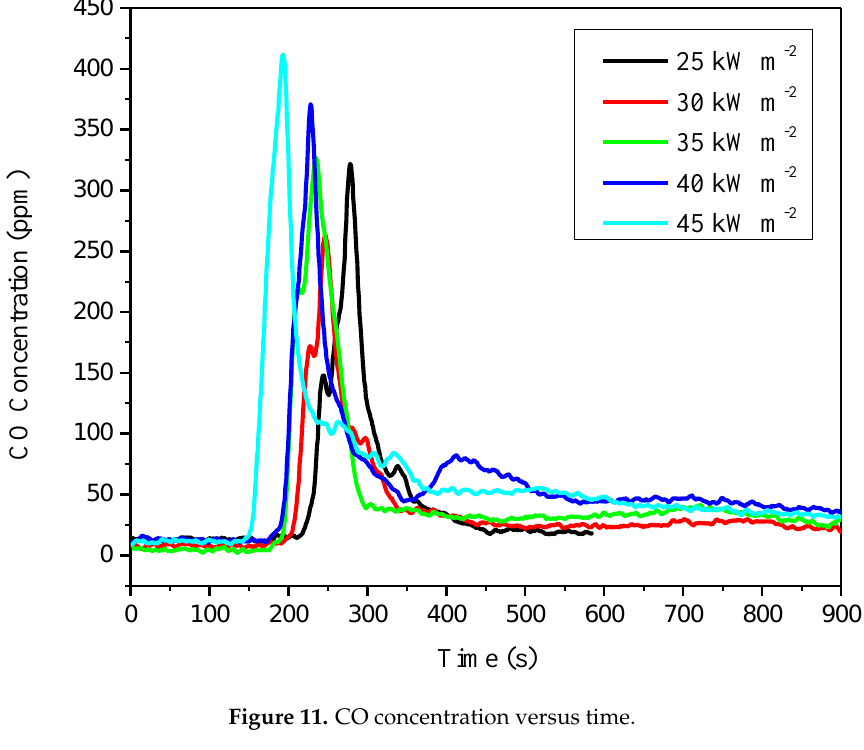
Figure 11. CO concentration versus time.